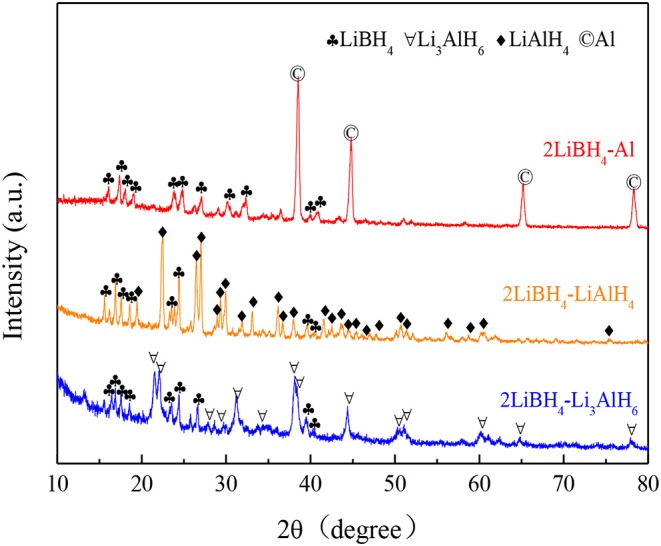
XRD patterns of 2LiBH4-Al, 2LiBH4-LiAlH4, and 2LiBH4-Li3AlH6 mixtures after ball milling for 1 h.